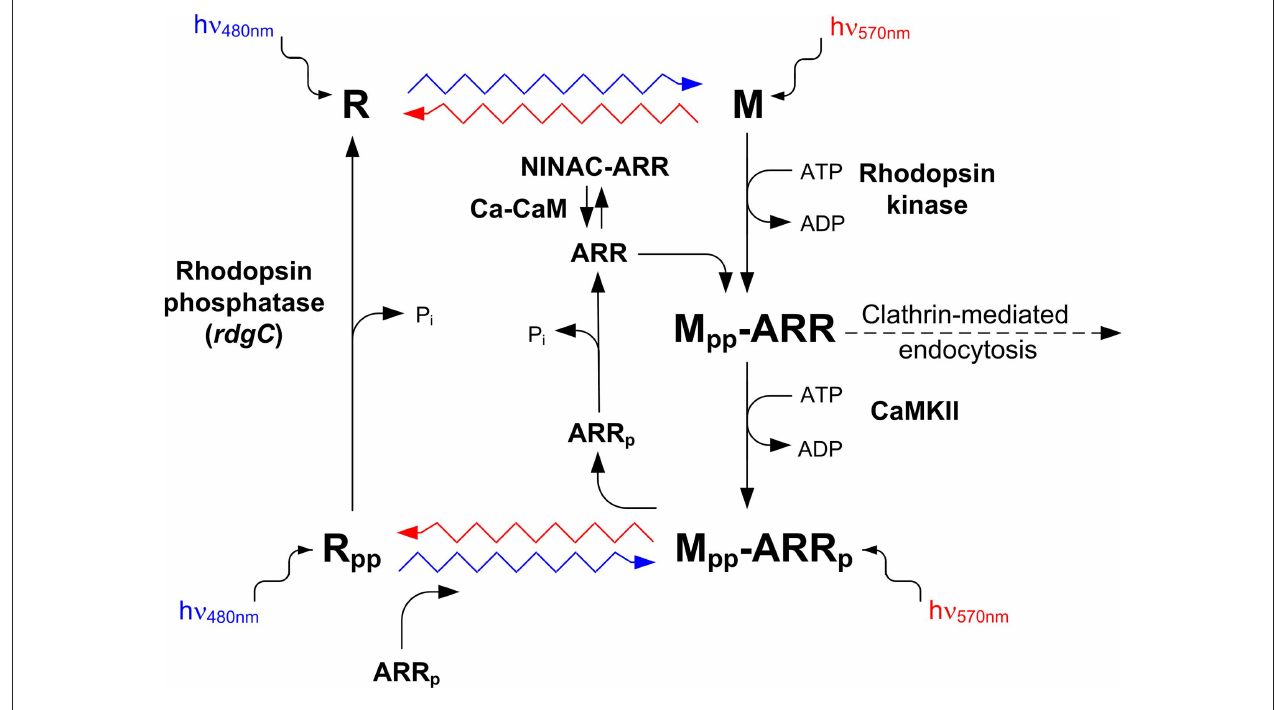
FIGURE 6 | The photochemical cycle: the “turn-on” and “turn-off” of the photopigment. Upon photoconversion of rhodopsin (R) to metarhodopsin (M), by illuminating with blue light (wavy blue arrow), M is phosphorylated at multiple sites by rhodopsin kinase and the fl y ARR2 binds to phosphorylated M. ARR2 is then phosphorylated by Ca 2 + calmodulin-dependent kinase (CaMKII). Photoconversion of phosphorylated M (Mpp) back to phosphorylated R (Rpp) is